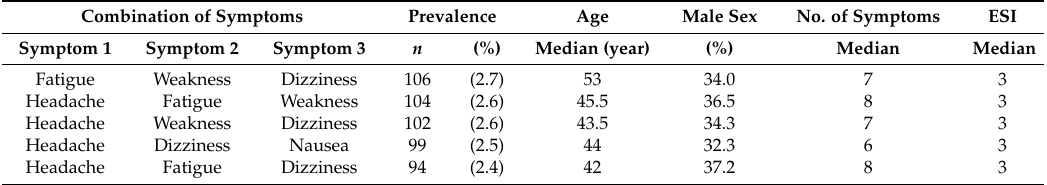
Table A1. Distribution of the 5 most frequent combinations of three symptoms.